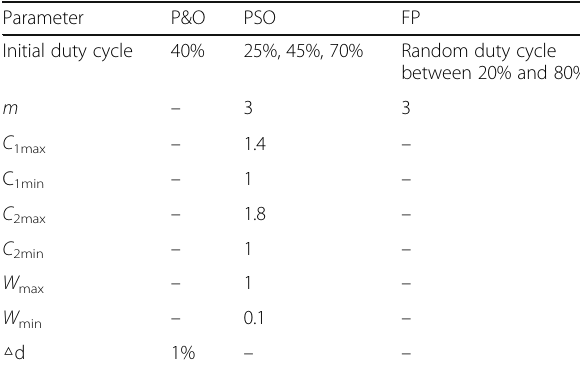
Table 2 Parameters of P&O, PSO and FP algorithm Parameter